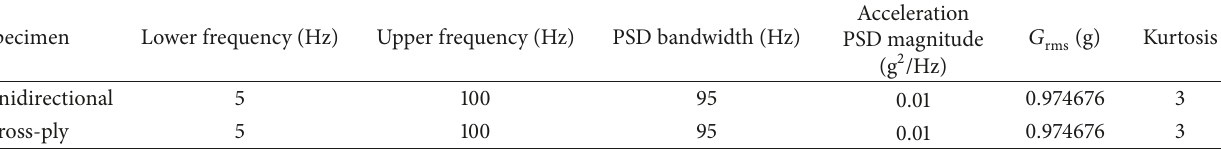
Table 3: The test conditions of Test 1.